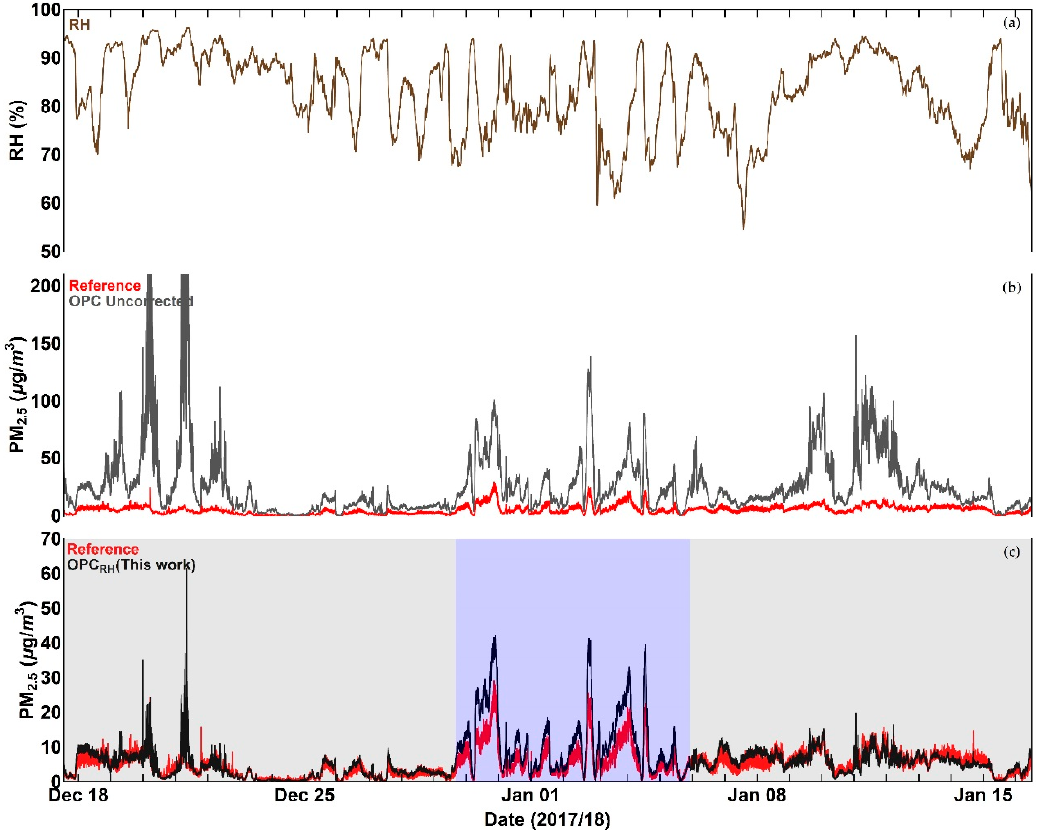
Figure 10. Time series plots of ( a ) Relative Humidity, ( b ) OPC PM 2.5 measurement in comparison with reference data before the application of the correction algorithm, and ( c ) OPC PM 2.5 measurement in comparison with reference after the application of the correction algorithm. The blue shaded area denotes a period during which the corrected PM values show a systematic overestimation compared to with reference data. More details are given in the text.